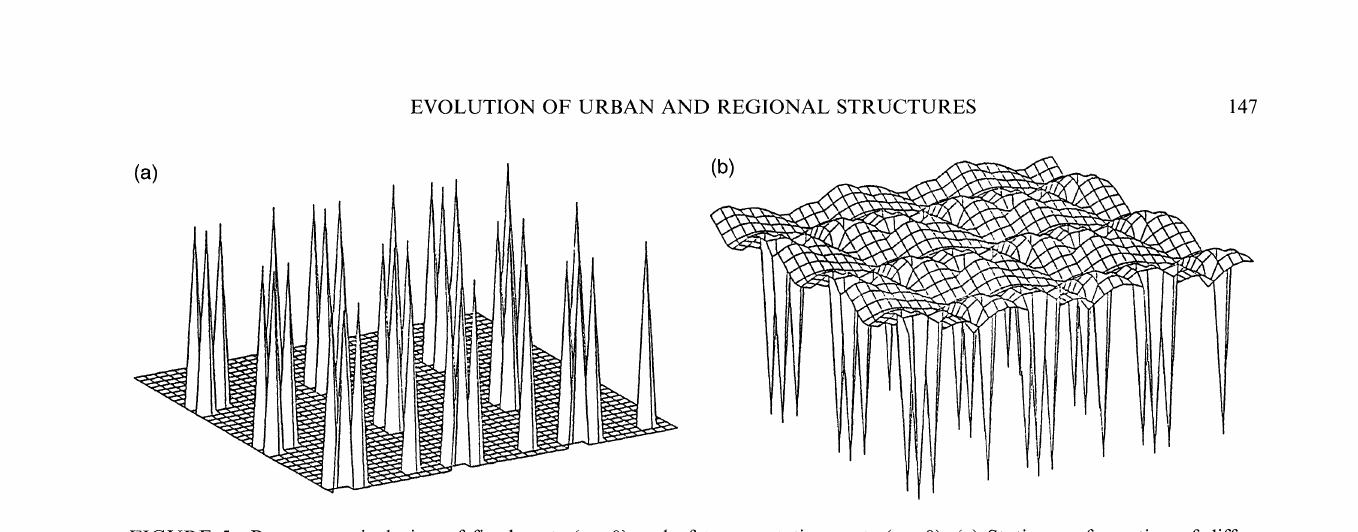
FIGURE 5 Parameters: inclusion of fixed costs (p > 0) and of transportation costs (or > 0). (a) Stationary formation of differ- entiated "town-structures" settled by "craftsmen" in each unit area. (b) Differentiated ring-shaped rural settlements of "peasants" around the